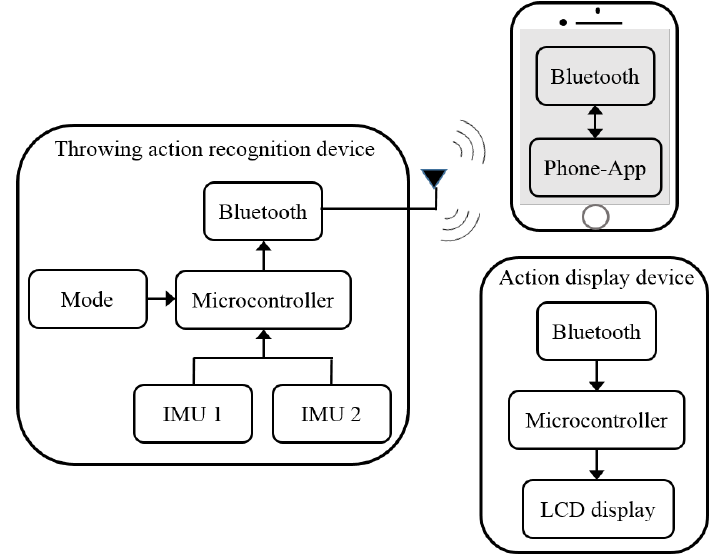
Figure 1. System architecture.